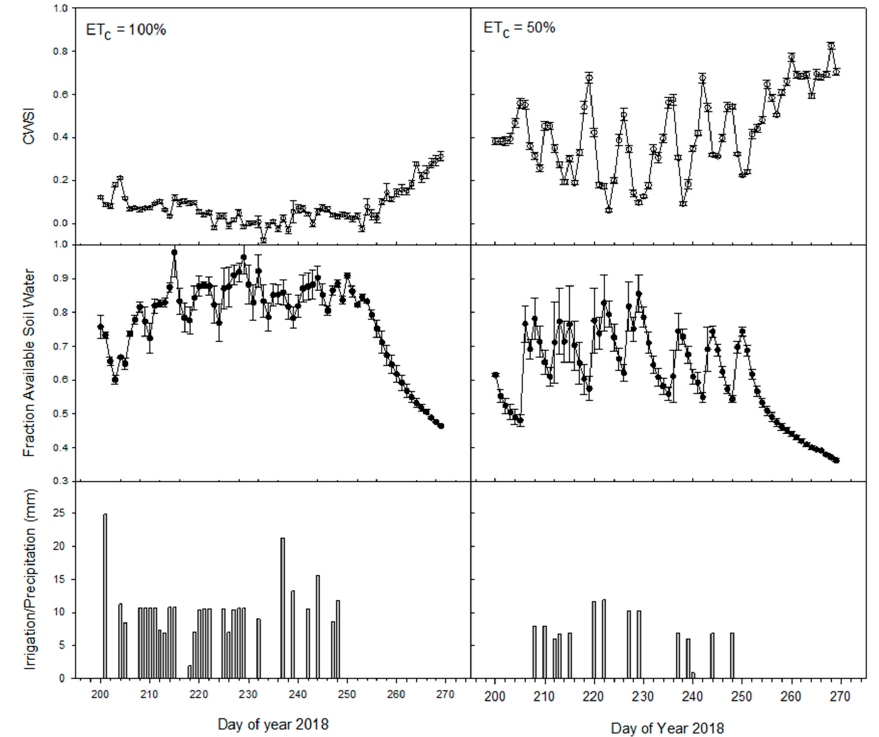
Figure 2. Crop water stress index ( CWSI ), fraction available soil water, and irrigation applications to treatments in 2018. Bars represent ± standard error of the